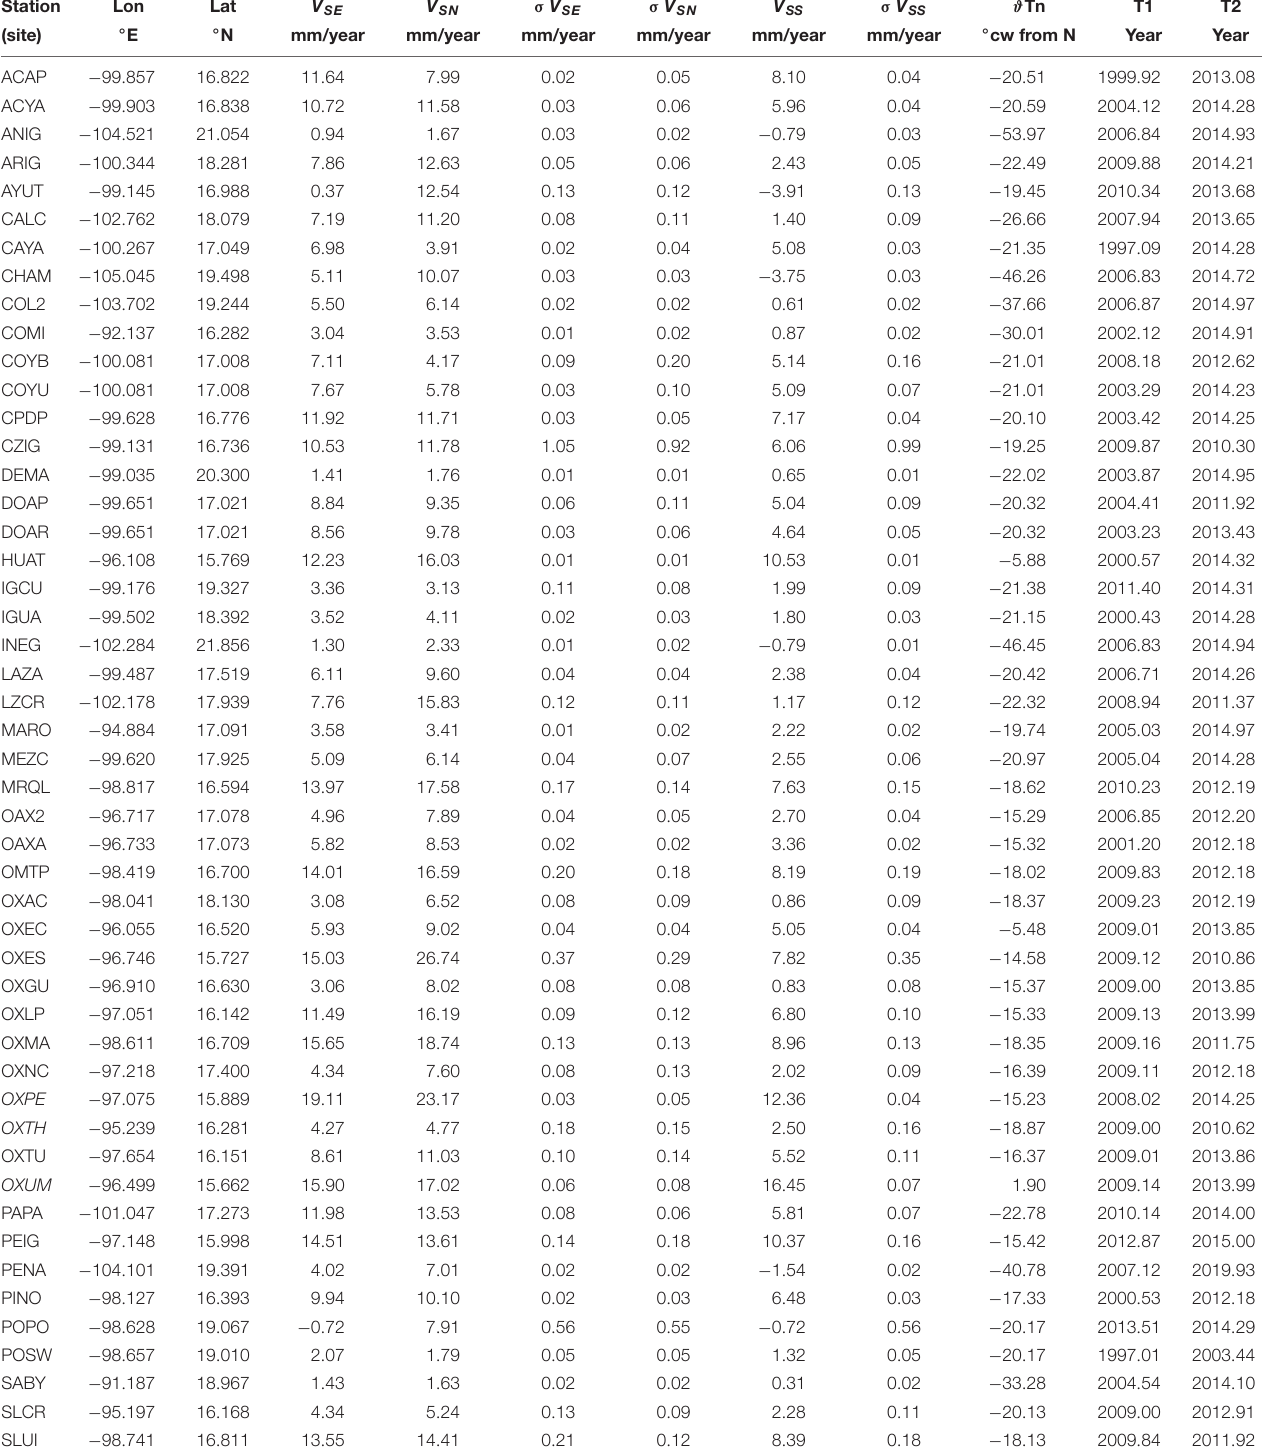
TABLE 1 | Secular velocities of the GPS stations ( V SE , V SN , east and north components accordingly, referenced to the fixed North America plate), and corresponding standard errors ( σ V s E , σ V s N ); trench parallel velocities ( V ss) with standard errors ( σ V ss) and azimuth of trench normal ( ϑ Tn, clockwise from North); T1 and T2 are the start and end limits of the fitting time span,